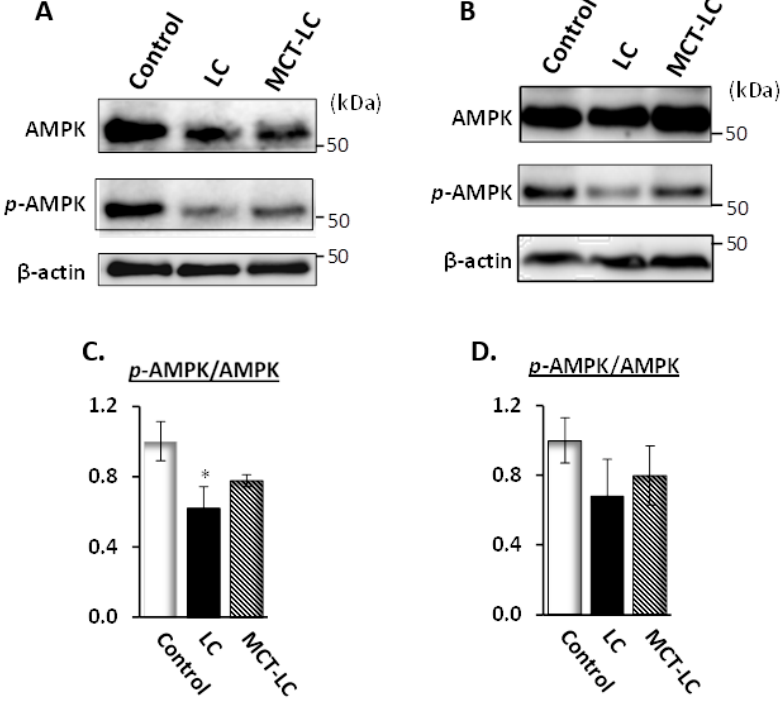
Figure 7. AMPK activation in renal sample ( A , C ) and hepatic sample ( B , D ). Data shown are mean ± SEM. Control, control diet; LC, low-carbohydrate diet high in lard; MCT-LC, low-carbohydrate diet high in medium-chain triglyceride. * p < 0.05 vs. control by Tukey’s HSD test.